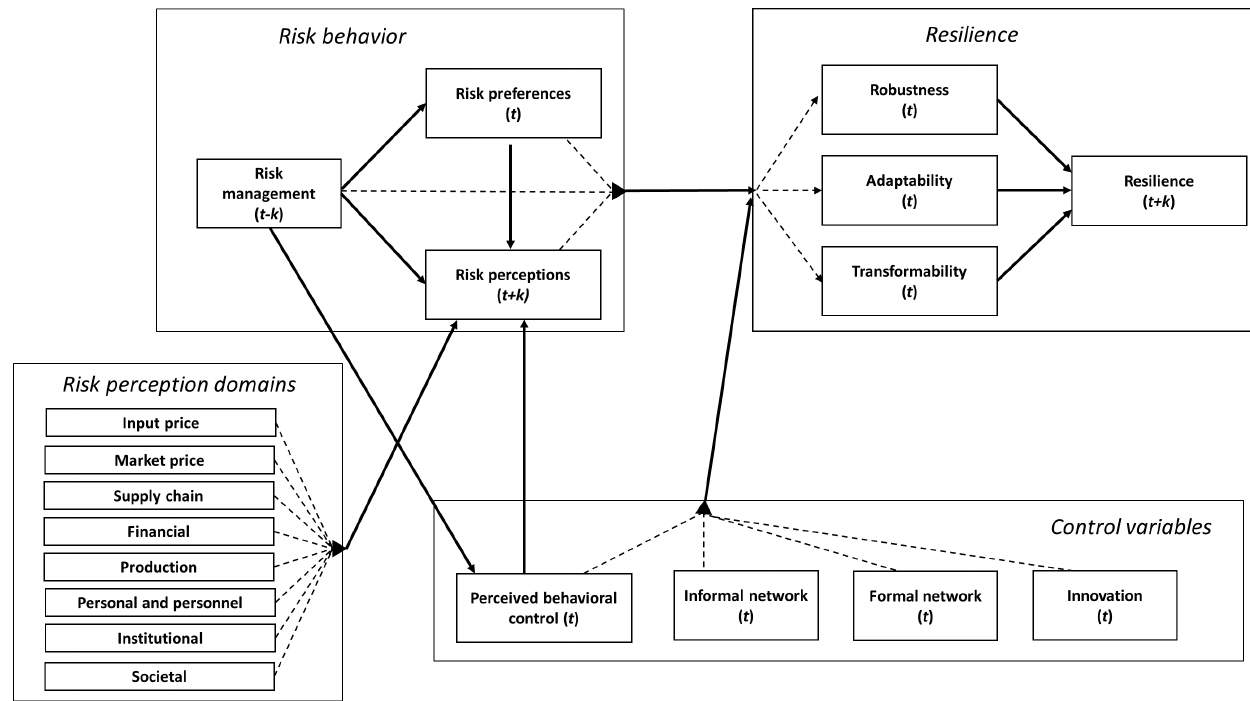
Fig. 1. Conceptual framework to assess perceived farm resilience. Past (t-k), current (t), and future (t+k) variables are included. The arrows from the control variables and risk behavior boxes to resilience indicate that all variables within the corresponding box relate to perceived robustness, adaptability, and